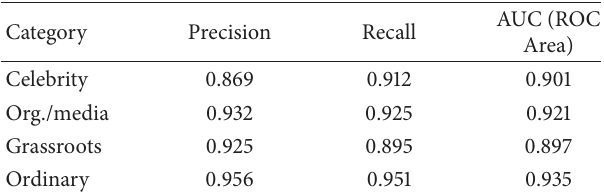
Table 3: Precision, Recall, and AUC results for each user